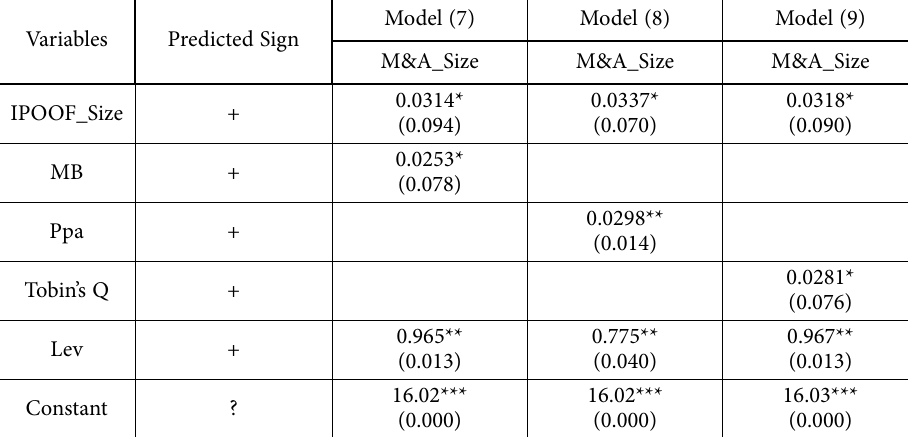
Table 12. Robust test: IPO over-financing, market overvaluation and the size of